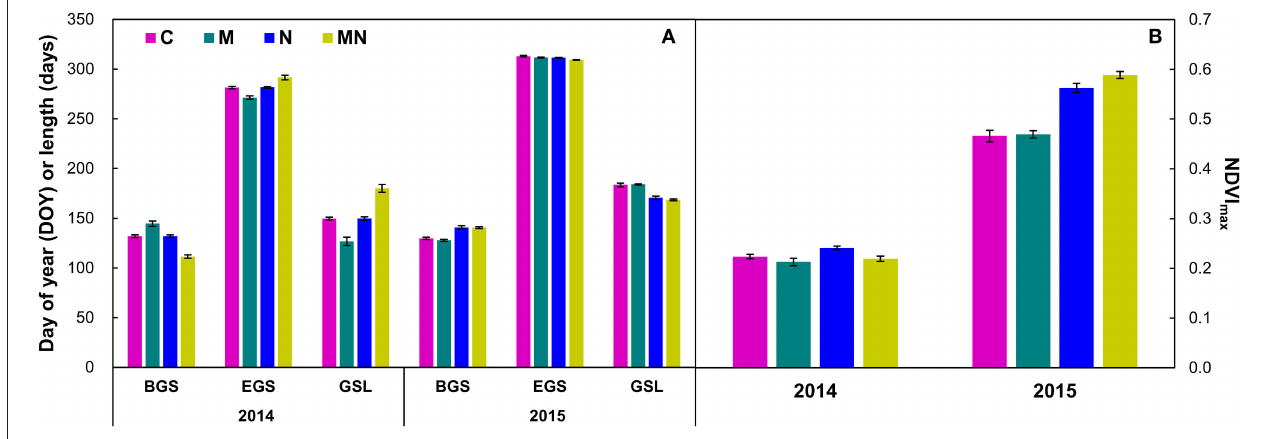
TABLE 2 | Results ( p -value) of two-way ANOVA on the effects of mowing, nitrogen addition, and their interactions on the BGS, EGS, GSL, and NDVI max in 2014 and 2015.